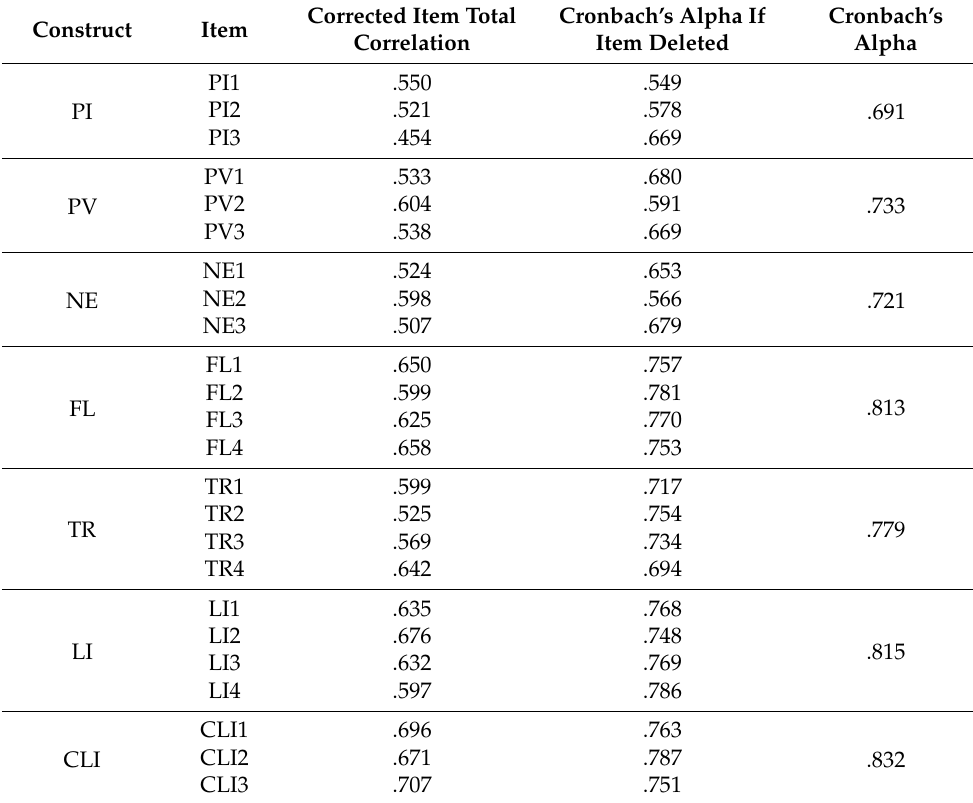
Table 3. Results of the reliability